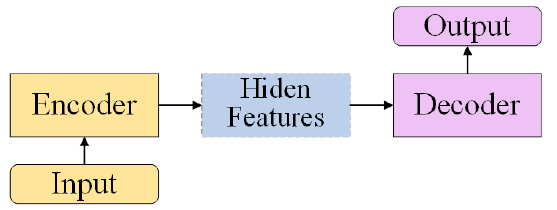
Figure 7. The abstract structure of the Encoder–Decoder framework.